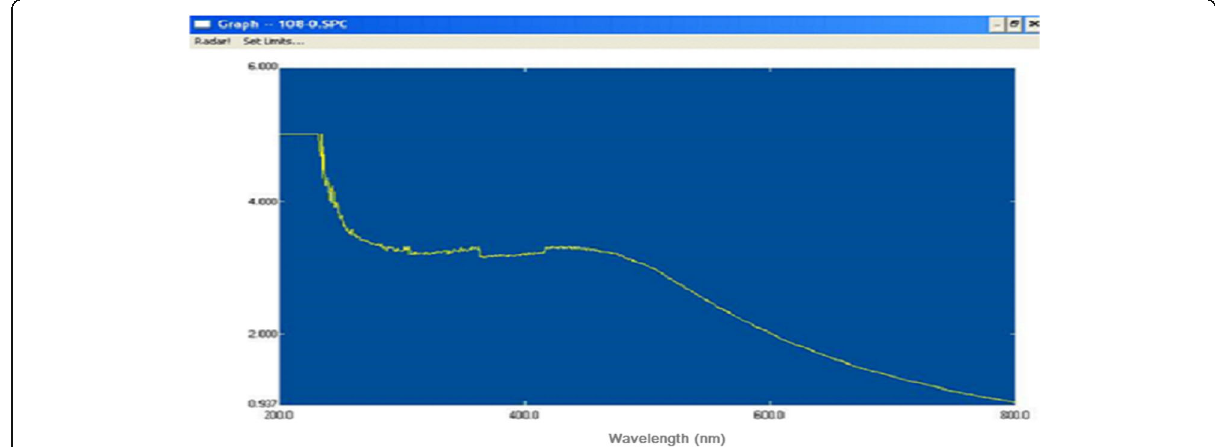
Fig. 1 UV – Vis absorbance spectra for nanocomposite. The long chain of BSEPS was adsorbed at the surface of a silver